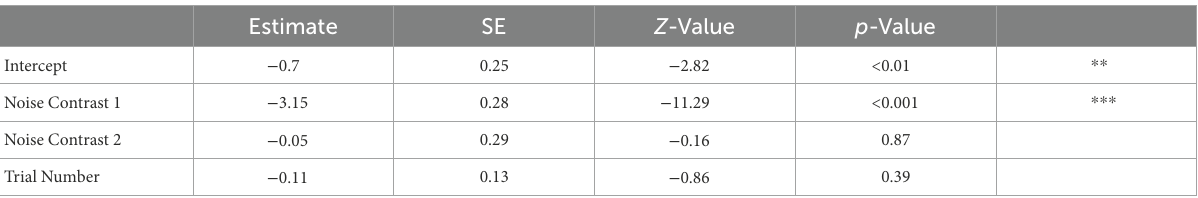
TABLE 4 Model outcomes for the subset of